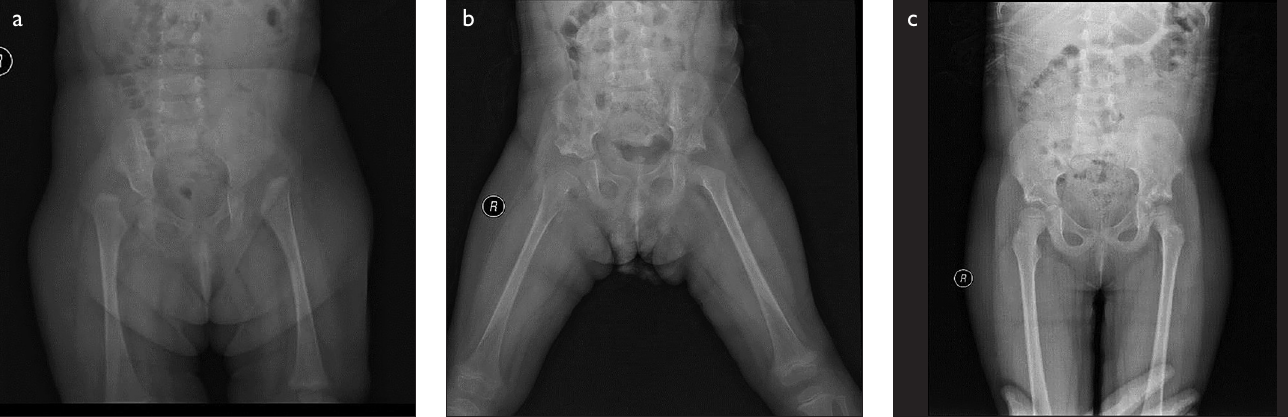
Figure 2. a-c. (a) A 12-month-old girl with right Tonnis type 3 and left Tonnis type 4 DDH. (b) Reluxation after closed reduction casting at month 13, bilateral Pemberton surgery was performed. (c) Postoperative month 36 of follow-up